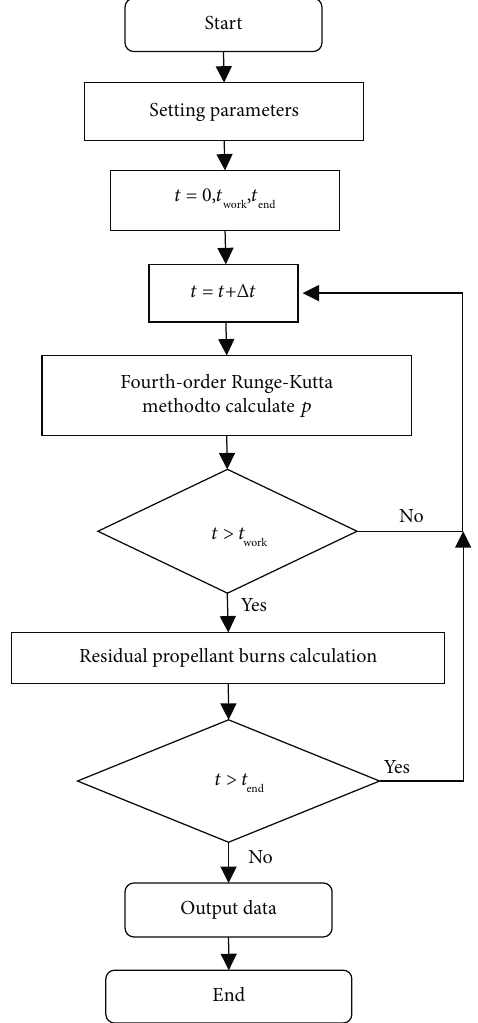
Figure 4: Computational fl ow chart for the internal ballistics of a pasty rocket